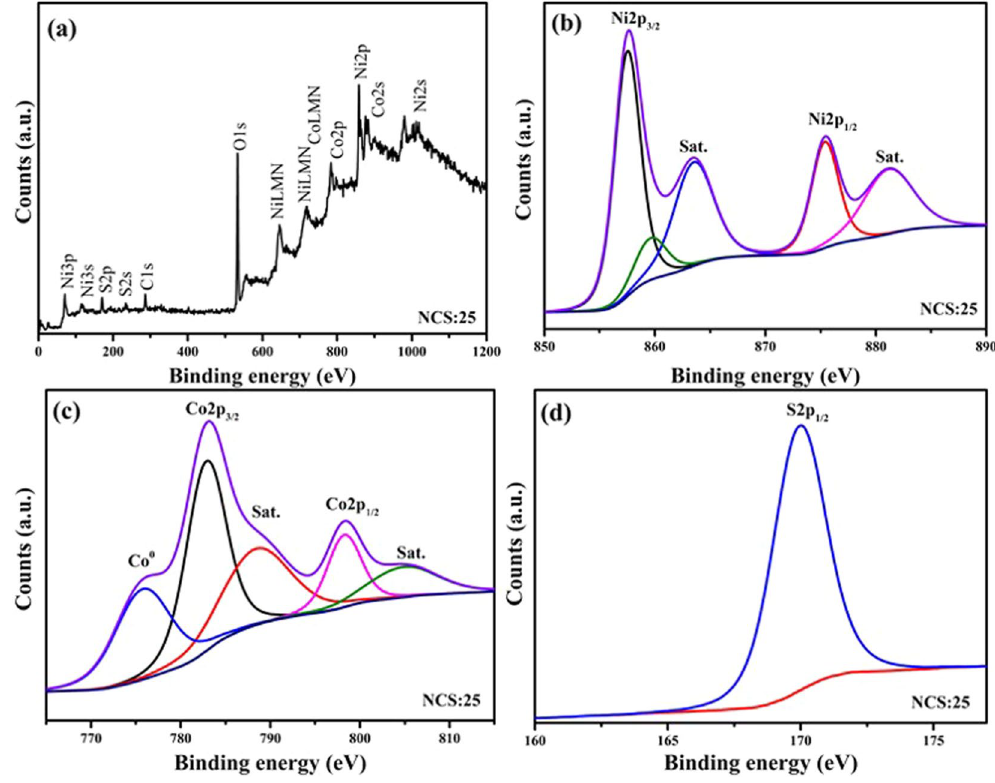
Figure 2. ( a ) Survey spectrum of the optimized NiCo 2 S 4 sample, ( b , c ) Core level spectra for Ni 2p, Co 2p, and S 2p, respectively, at optimized sample NCS:25 thin film on Ni